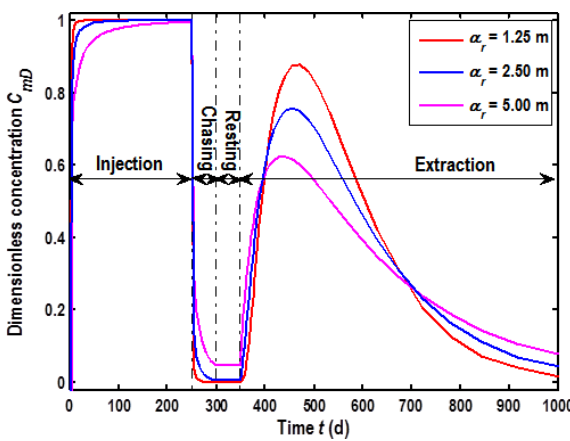
Figure 7. BTCs in the wellbore for different α r .